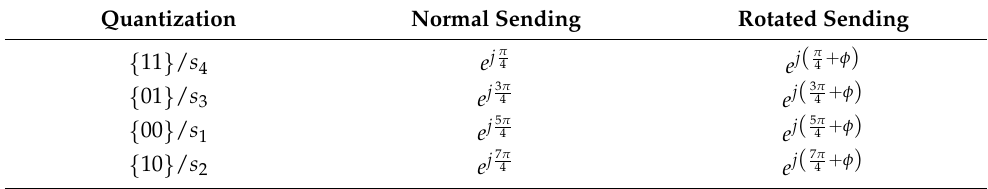
Table 1. The relationship between the quantization value and the transmitted signal for the 2-bit case.